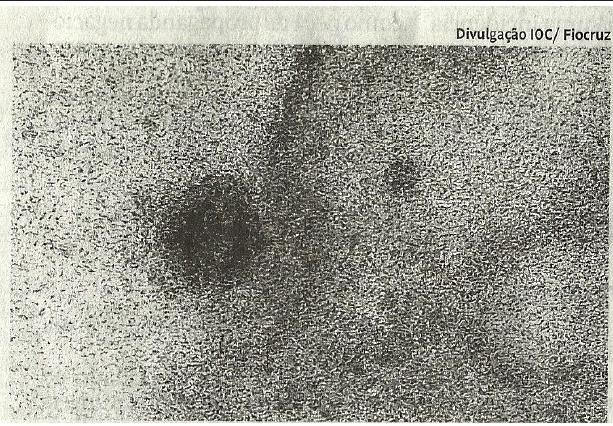
FIGURA 5 – Vírus internalizado na célula hospedeira